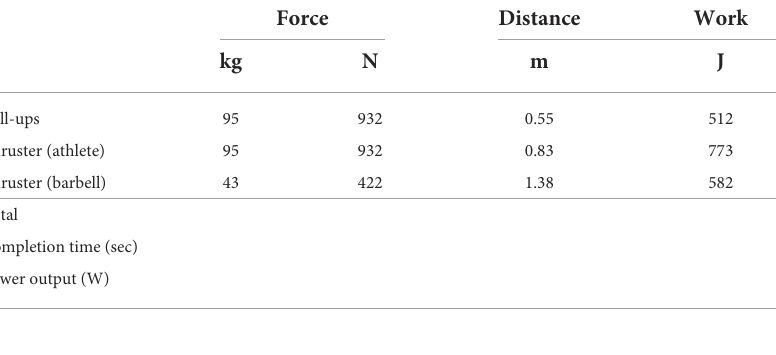
TABLE 2 Workload and power output estimate for the benchmark workout